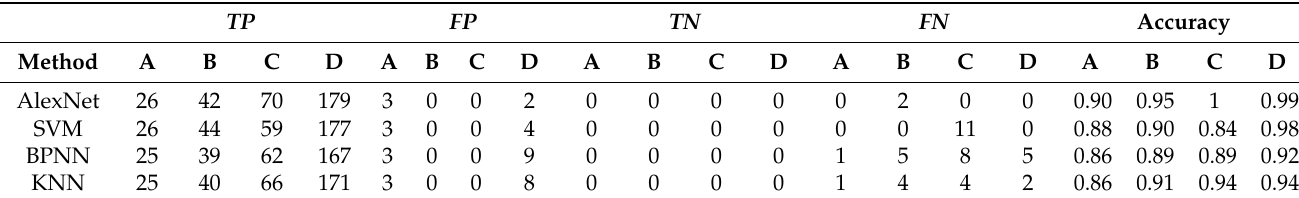
Table 9. Comparative analysis of average